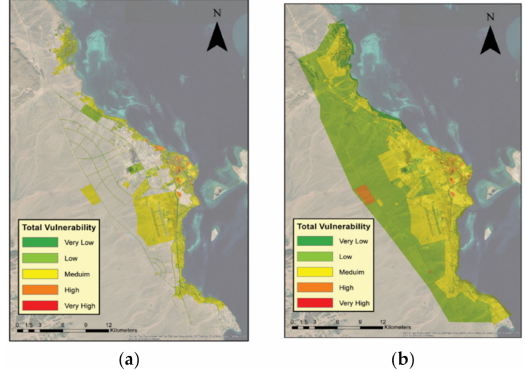
Figure 8. ( a ) Current total vulnerability and ( b ) future total vulnerability in